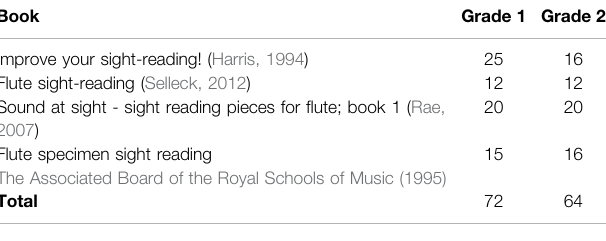
TABLE 1 | Summary of expert-written example exercises extracted from published